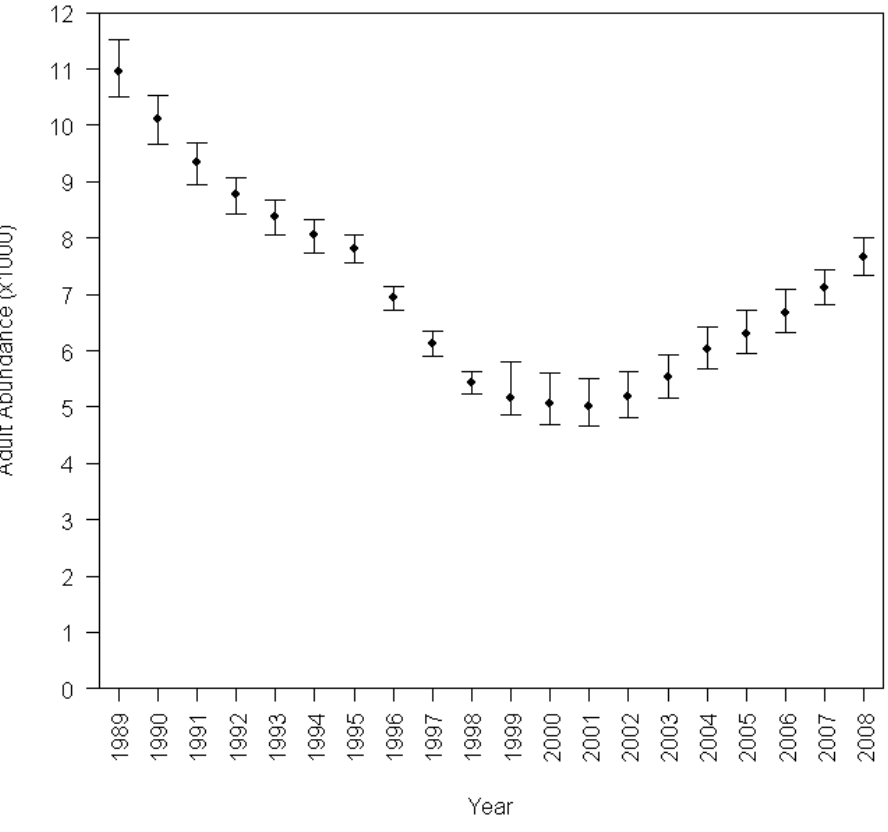
Figure A1.2. Adult abundance (age-4+) of humpback chub in the Little Colorado River population of Grand Canyon National Park, from Coggins and Walters (2009). Estimates are from mark-recapture analysis of PIT tagging data (Coggins et al. 2006 a ). Error bars show effect on the estimates of aging error due to estimating fish ages from lengths since destructive sampling for structures that carry age information (e.g. otoliths) is not allowed for this endangered